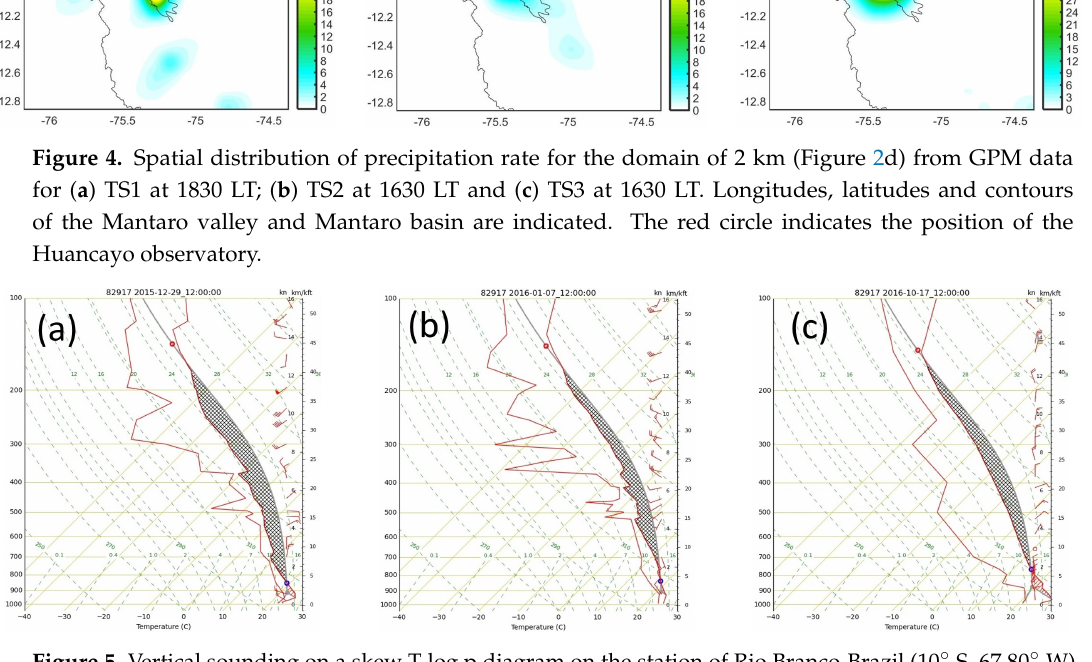
Figure 5. Vertical sounding on a skew T-log p diagram on the station of Rio Branco-Brazil (10 ◦ S, 67.80 ◦ W) at 12Z (07 LT) for the ( a ) TS1; ( b ) TS2 and ( c ) TS3. The diagram shows the lifting condensation level, the free convection level and the level of neutral